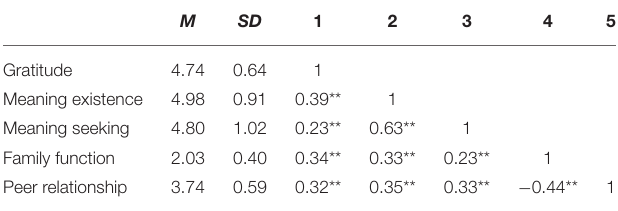
TABLE 1 | Descriptive statistics of main